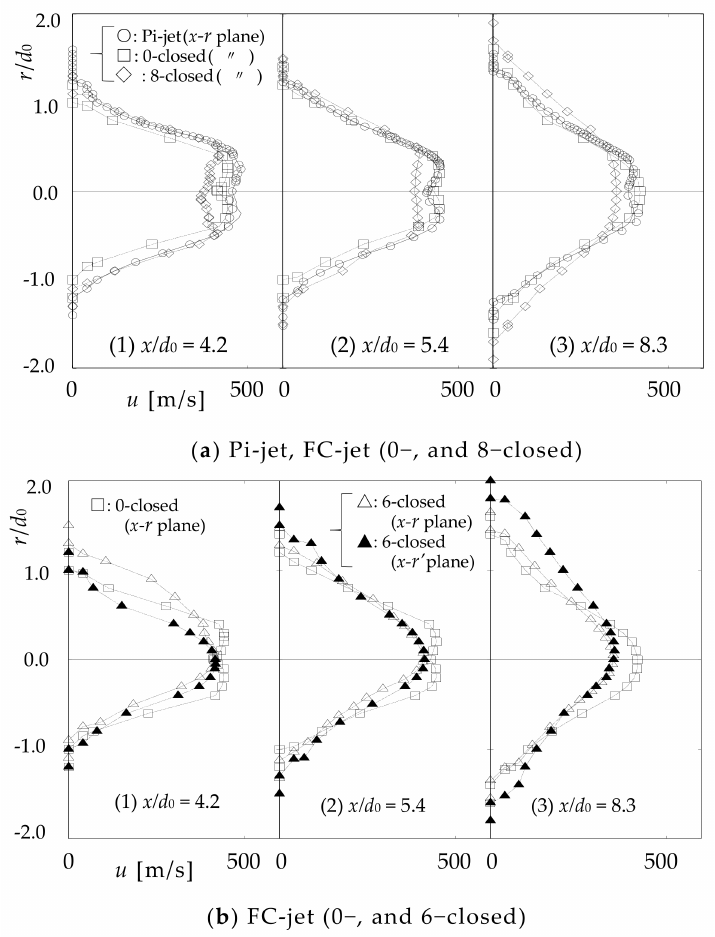
Figure 9. Cross sectional velocity distribution at x / d 0 = 4.2, 5.4, 8.3 ( P 0 = 0.38 MPa, P s = P a ): The maximum velocity of the 0 − closed case is approximately equal to that of the Pi-jet and is larger than that of the 8 − closed